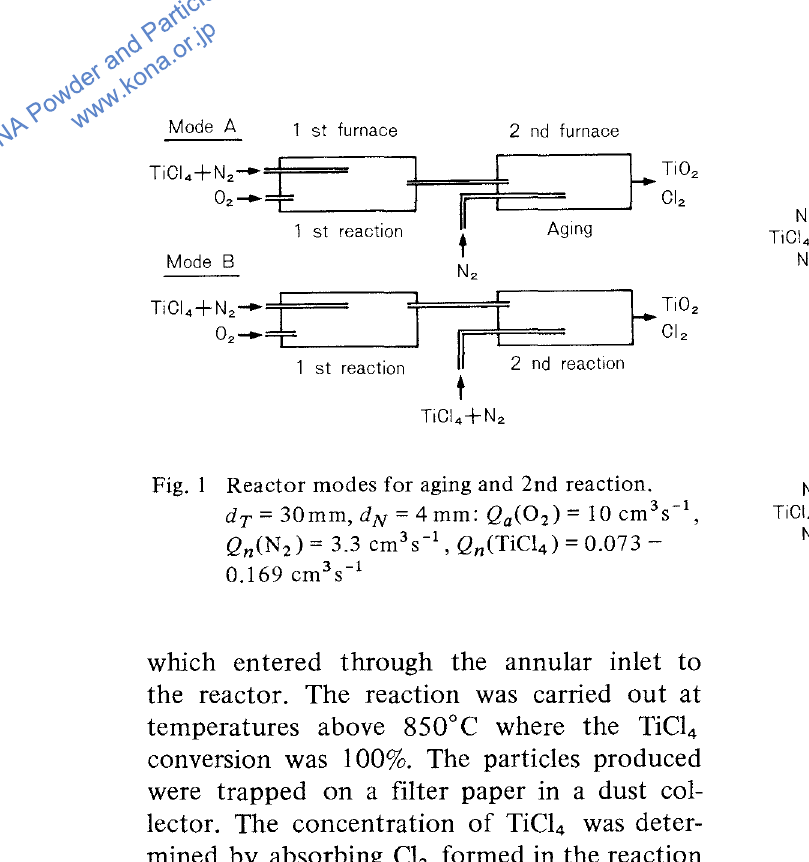
Fig. I Reactor modes for aging and 2nd reaction. dr = 30mm, dN = 4 mm: Qa(02) = 10 cm 3 s- 1 , Qn(N 2 ) = 3.3 cm 3 s- 1 , Qn(TiC1 4 ) = 0.073-